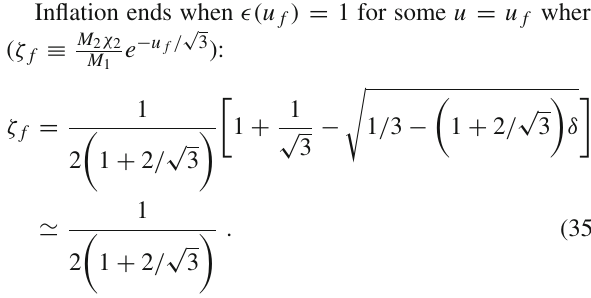
Fig. 3 NumericalexampleoftheHubbleparameter H ( t ) andthescalar field u ( t ) vs. time. For short times the inflationary Hubble parameter is large and afterwards approaches its cosmological late time value. As (cid:10) 10 − 2 , H ( 0 ) ∼ 1, u ( 0 ) ∼ 17. The phys- an example we take: M 1 M 2 χ 2 ical units for the numbers representing u and H on the vertical axis in both graphics conform to our choice of normalization of “Planck” units 16 π G Ne w ton = 1 in Eq. (5) and henceforth. Thus, the physical